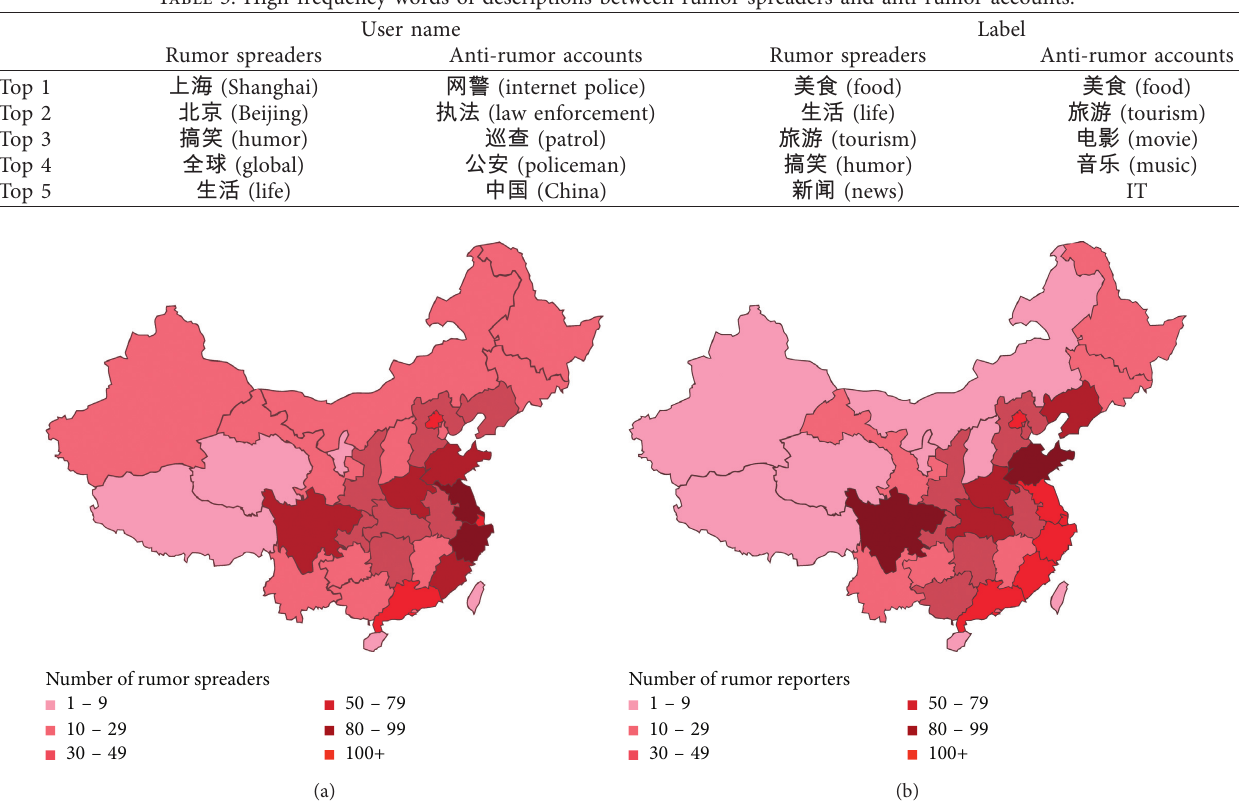
Table 3: High-frequency words of descriptions between rumor spreaders and anti-rumor